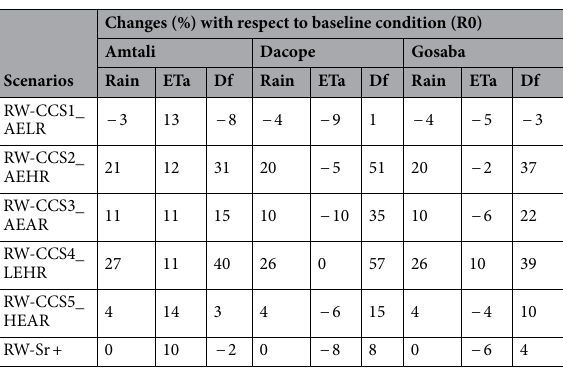
Table 5. Changes (%) in rainfall, actual evapotranspiration (ETa) and surface runoff (Df) in the coastal polders under combined effects of climate change and land management